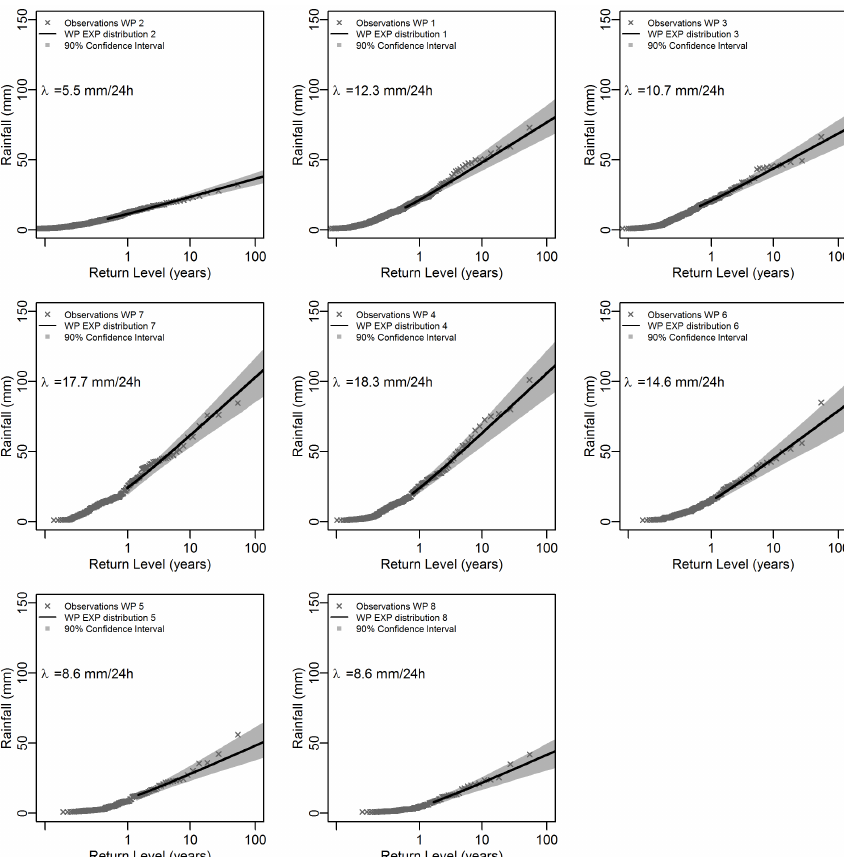
Fig. 8. Exponential distributions of the eight WP sub-samples for Lyon rain gauges (data from the period 1953–2005; “season-at-risk” (June to November)). The gray zone highlights the 90% confidence intervals.